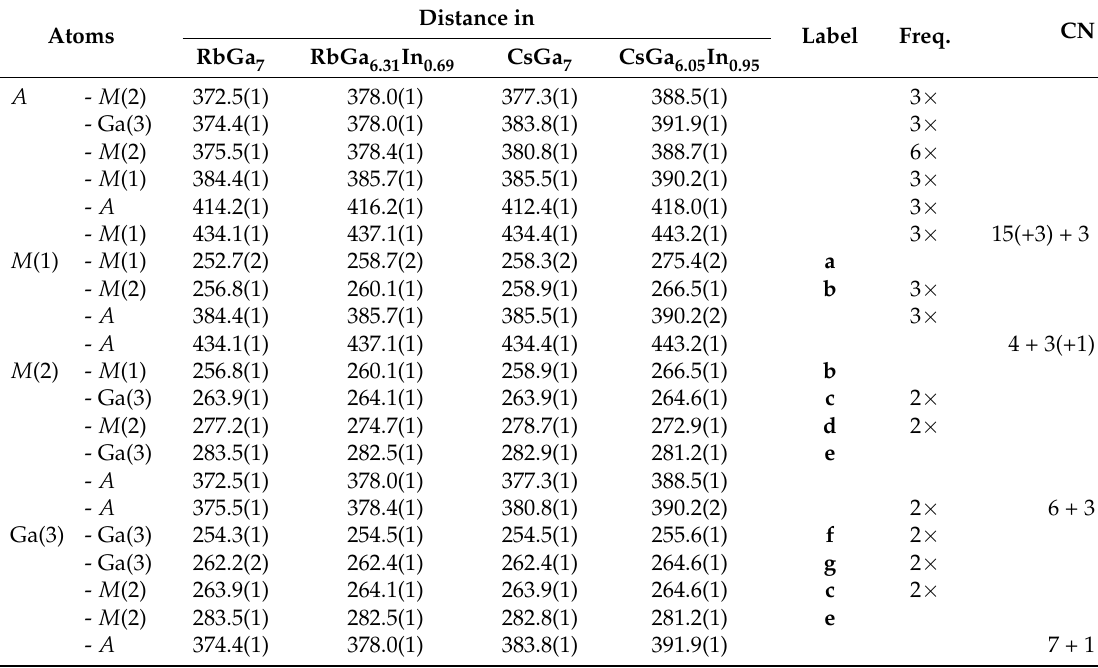
Table 4. Selected interatomic distances/pm in the crystal structures of the compounds forming the RbGa -type 7